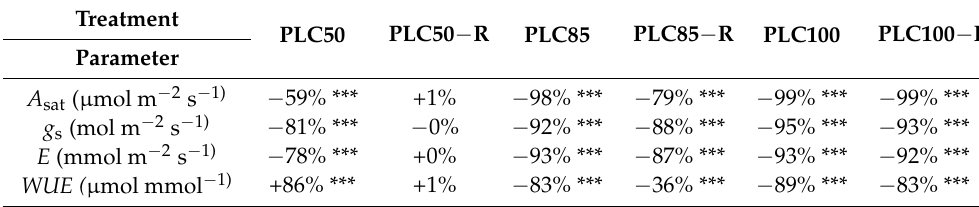
Table 2. The percentage differences in drought compared with control at the target drought stress (PLC50, PLC85, and PLC100) and 15 days after rehydration (PLC50 − R, PLC85 − R, and PLC100 − R). “+” means increase, and “ − ” means decrease. “***” means extremely significant differences between drought and control ( p <